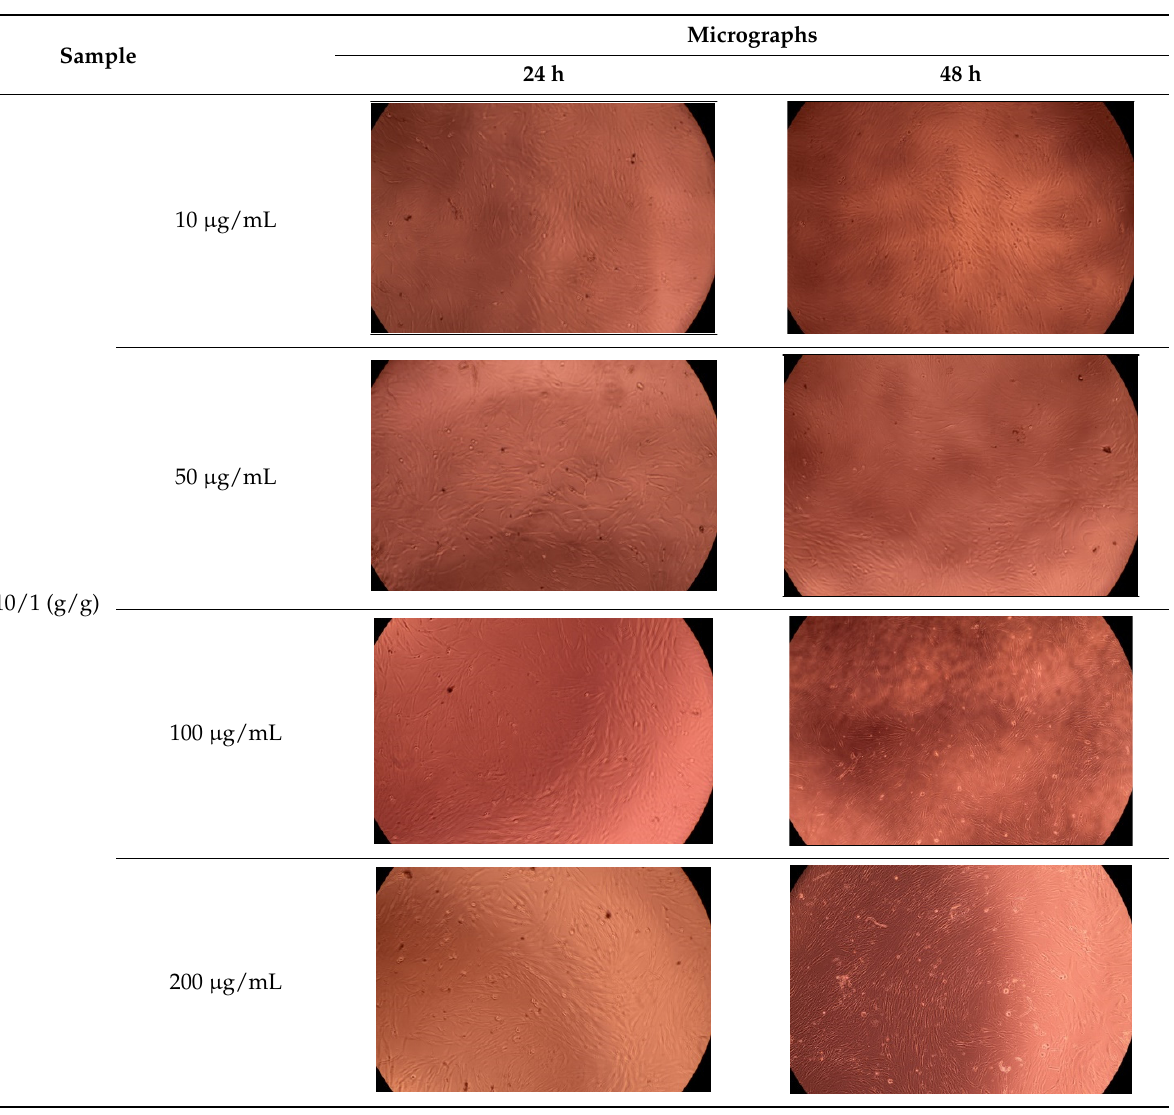
Table 4. Inhibition zone diameter (mm) for different bacterial strains in the presence of free PMs, free API and API-loaded PMs. Concentration was equal to 200 µg/mL.